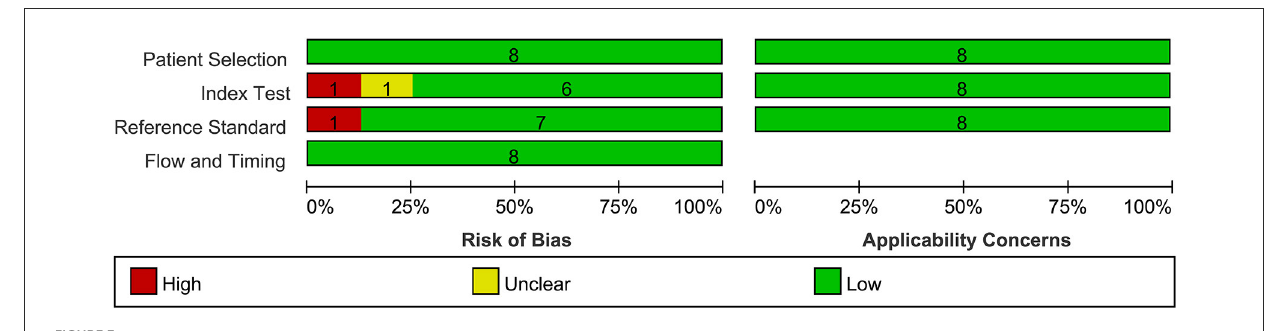
FIGURE3 Summary of risk of bias and applicability of concerns